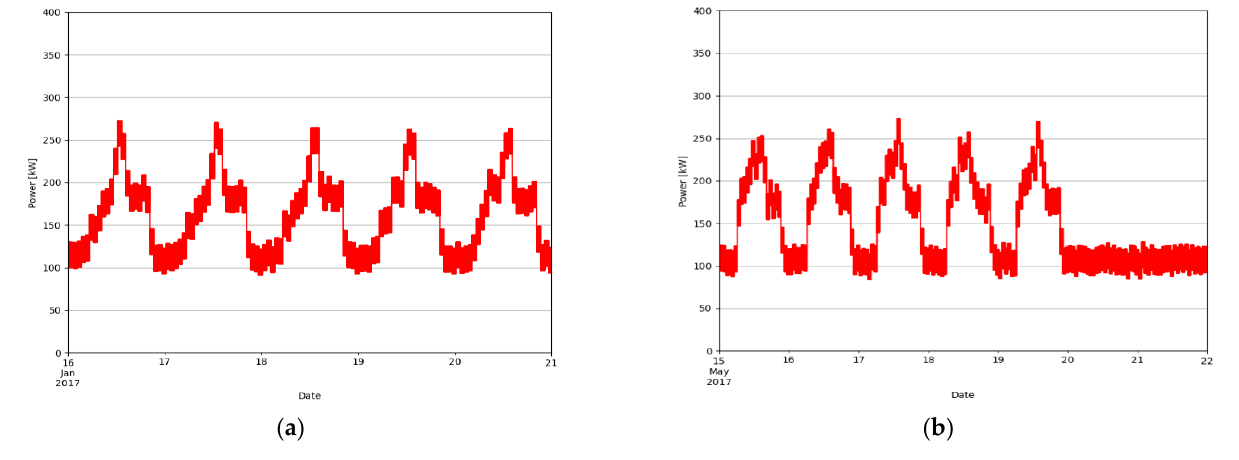
Figure 8. Power data for the global consumption, ( a ) Training Period, ( b ) Test Period.